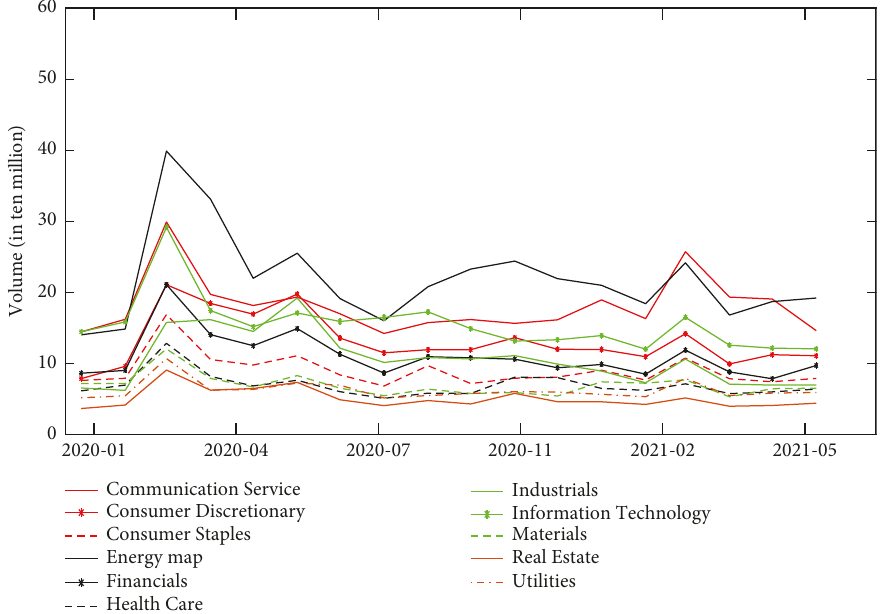
Figure 4: The MATV for 11 sectors from January 2020 to July